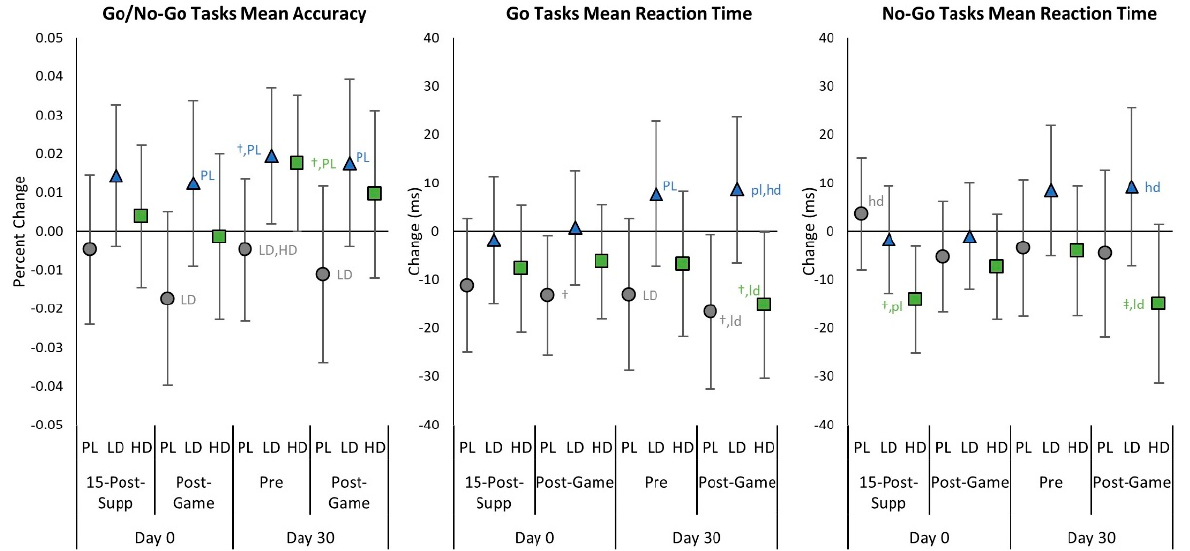
Figure 5. Go/No-Go Task test mean changes with 95% confidence intervals from Day 0, pre-game (Pre) values for the placebo (PL), low-dose (LD), and high-dose (HD) groups. † represents p < 0.05 from Pre values while ‡ represents p > 0.05 to p < 0.10 effect. 15-min-Post-Supp represents data obtained 15 min after supplementation, and Post-Game represents data obtained after competitively playing video games for 60 min. Group differences ( p < 0.05) are shown as differences from placebo (pl), low-dose (ld), and high-dose (hd) groups, while statistical tendencies ( p > 0.05 to p < 0.10) are shown in large cases (PL, LD, HD).